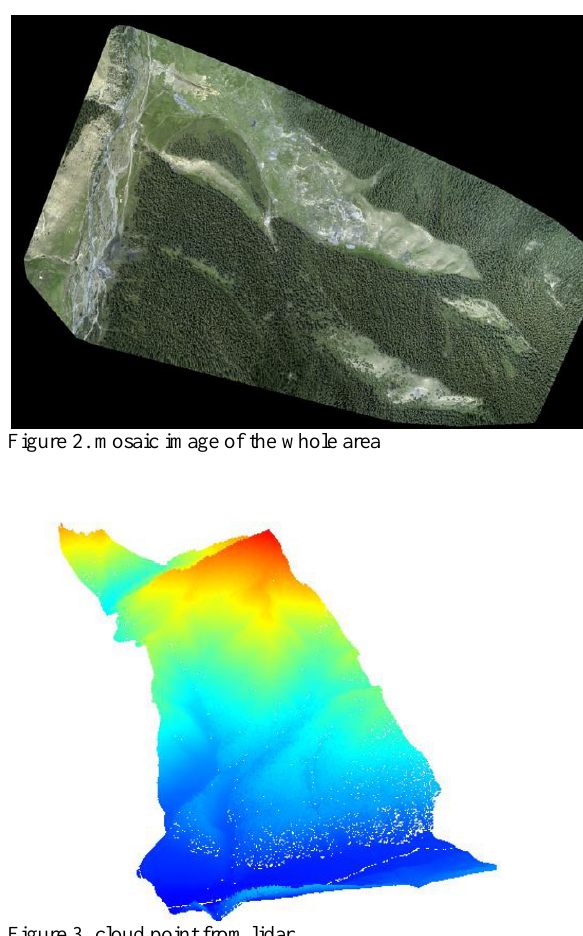
Figure 3. cloud point from lidar